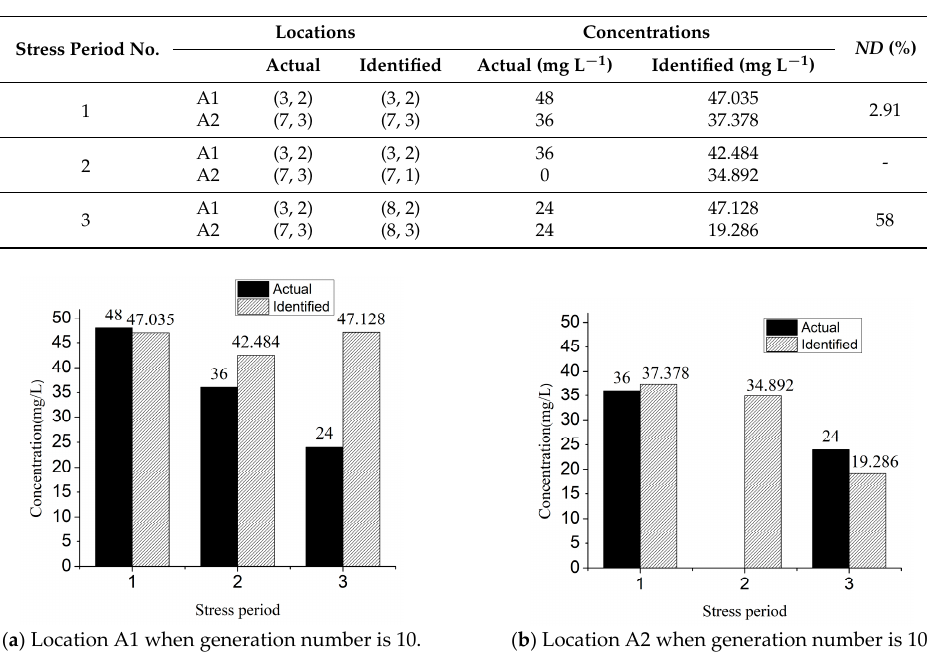
Figure 11. Identified results of A1 ( a ) and A2 ( b ) when generation number is 10.